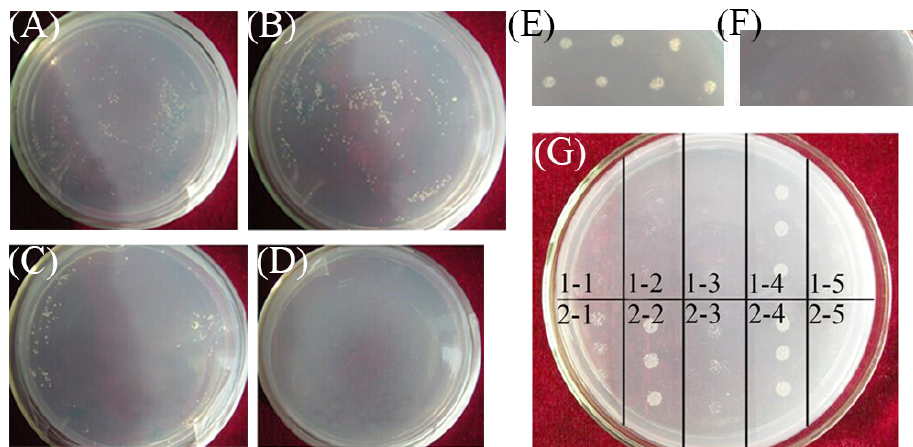
Figure 2. Transcription activation and the CRT/DRE binding activity analysis. ( A ) and ( C ) respectively exhibited the growth of yeast cells harboring the pGBKT7 ‐ CsCBF2AD recombinant plasmid on SD/ ‐ Trp and SD/ ‐ Trp/ ‐ His/ ‐ Ade plate. ( B , D ) respectively exhibiting the growth of yeast cells harboring the pGBKT7 ‐ CsCBF2 recombinant plasmid on SD/ ‐ Trp and SD/ ‐ Trp/ ‐ His/ ‐ Ade plate. ( E , F ) respectively display the growth of yeast cells harboring the pGADT7 ‐ Rec2 and pHIS2.1 plasmids on SD/ ‐ Trp/ ‐ His/ ‐ Leu plated with no 3 ‐ amino ‐ 1, 2, 4 ‐ triazole (3 ‐ AT) and 25 mM 3 ‐ AT. ( G ) The growth of yeast cells harboring the pGADT7 ‐ Rec2 ‐ CsCBF2BD and pHIS2.1 ‐ 4 × CRT/DRE, pGADT7 ‐ Rec2 ‐ CsCBF2BD and pHIS2.1 ‐ 4 × mCRT/DRE, pGADT7 ‐ Rec2 ‐ CsCBF2 and pHIS2.1 ‐ 4 × CRT/DRE, pGADT7 ‐ Rec2 ‐ CsCBF2 and pHIS2.1 ‐ 4 × mCRT/DRE on SD/ ‐ Trp/ ‐ His/ ‐ Leu plated with 25 mM 3 ‐ AT. 1 ‐ 1, the growth of yeast cells harboring the pGADT7 ‐ Rec2 ‐ CsCBF2 and pHIS2.1 ‐ 4 × mDRE; 1 ‐ 2, the